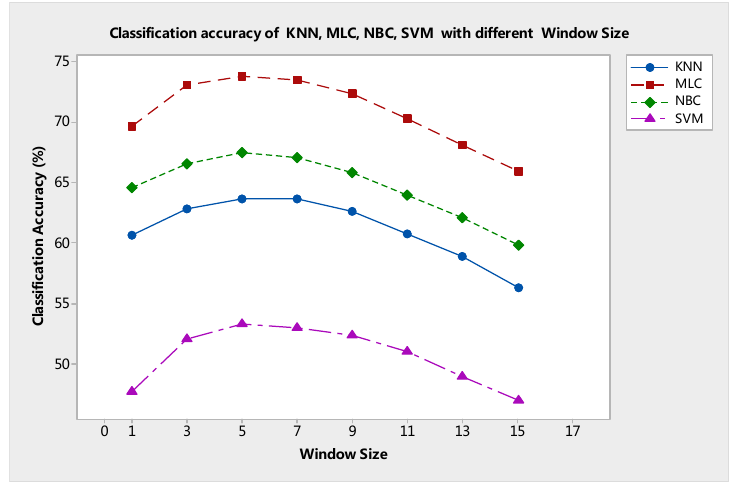
Figure 12. The relationship between OA and filter window size (r).